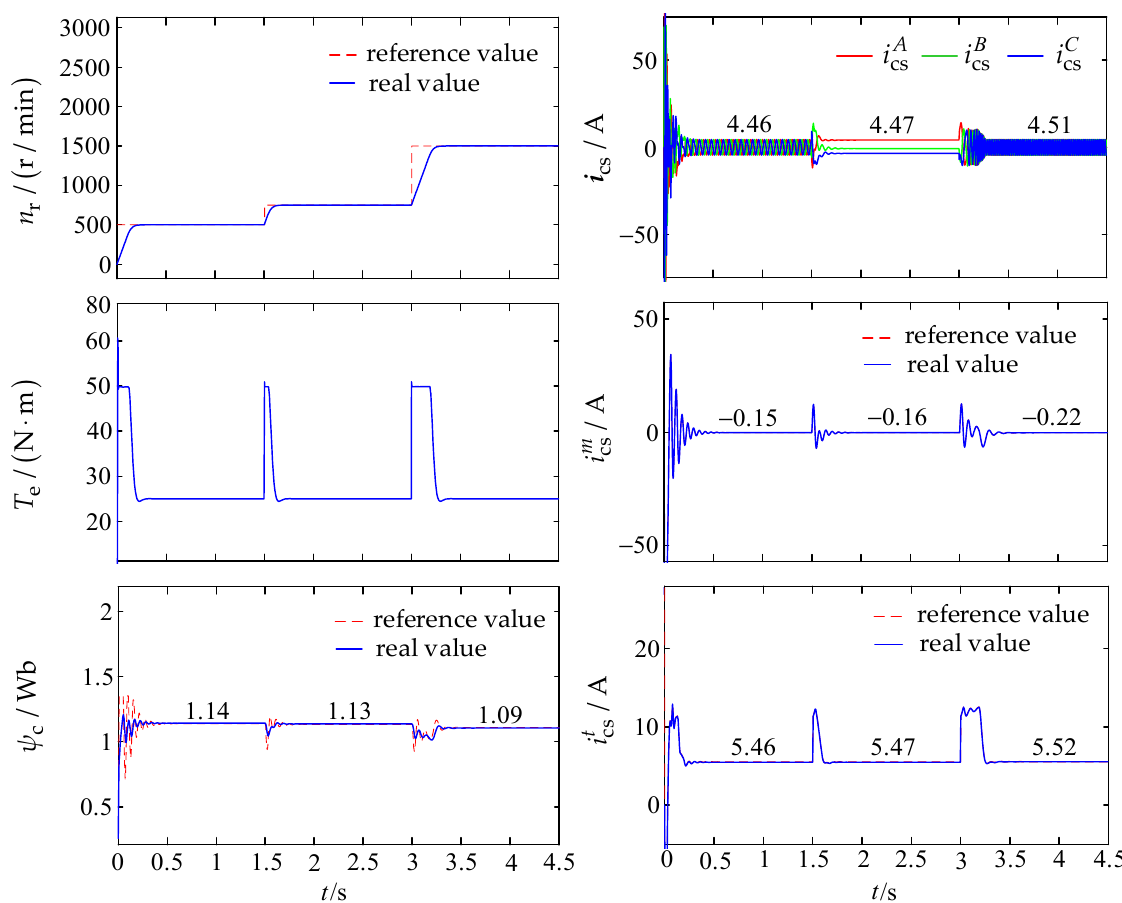
Figure 16. Simulation results of MTPA control when speed changes.